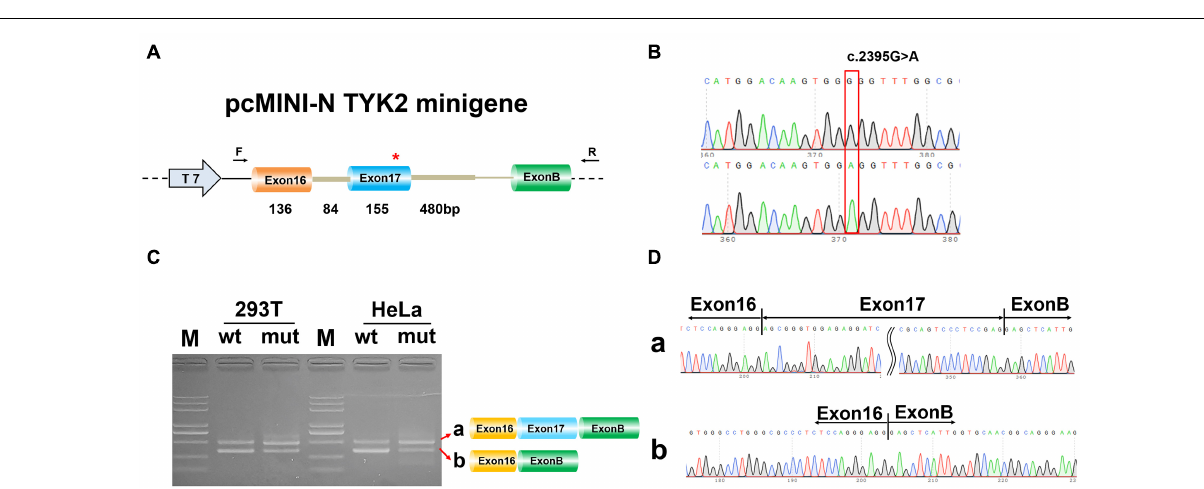
Supplementary Table 1 | Primer sequence information. Supplementary Table 2 | Database prediction